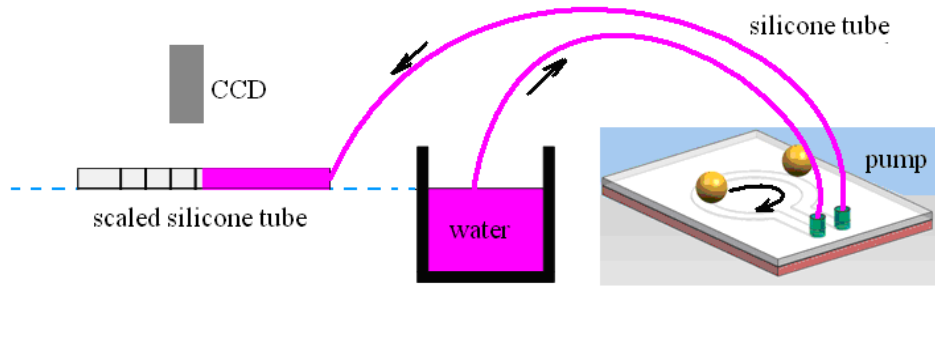
Figure 4. Schematic of the setup for flow rate